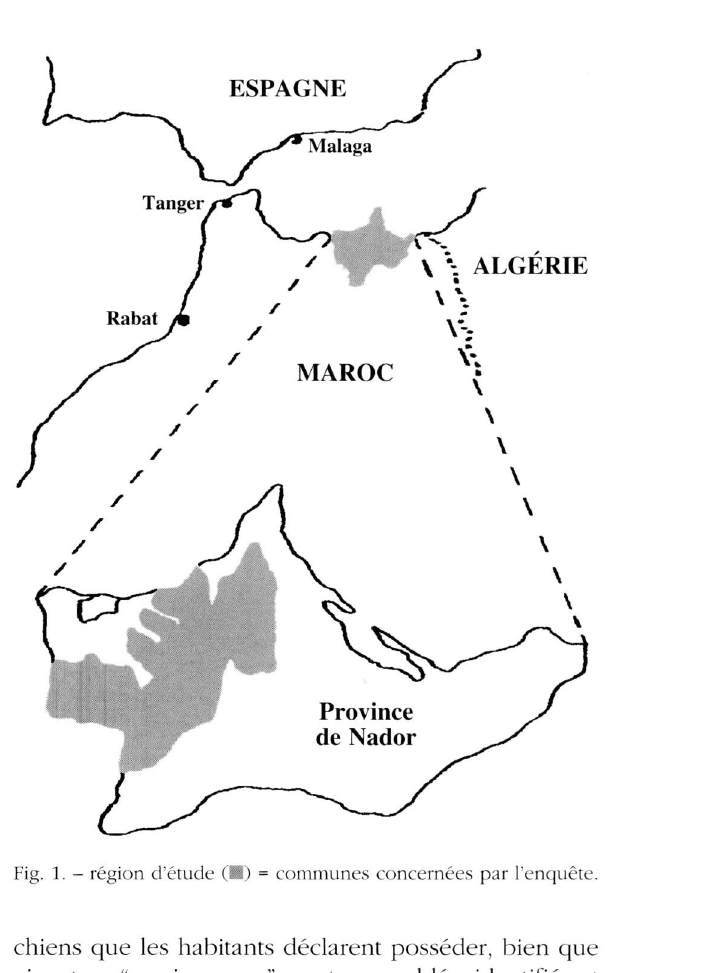
chiens que les habitants déclarent posséder, bien que vivant en "semi-errance", sont rassemblés, identifiés et font l'objet d'un examen clinique axé sur la recherche des symptômes de la leishmaniose, d'une prise de sang et, lorsque les symptômes relevés laissent sus pecter la maladie, d'une ponction du ganglion